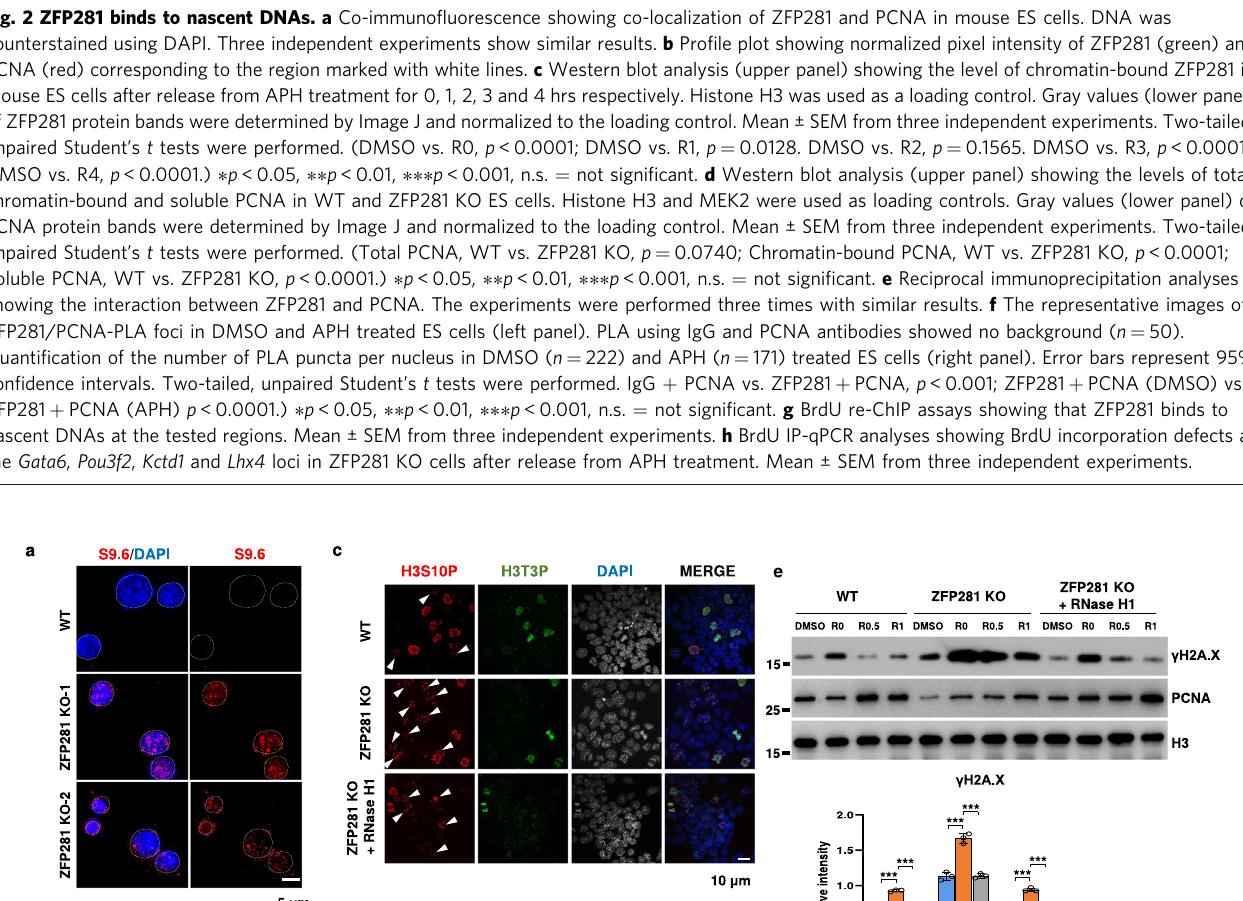
Fig. 2 ZFP281 binds to nascent DNAs. a Co-immuno fl uorescence showing co-localization of ZFP281 and PCNA in mouse ES cells. DNA was counterstained using DAPI. Three independent experiments show similar results. b Pro fi le plot showing normalized pixel intensity of ZFP281 (green) and PCNA (red) corresponding to the region marked with white lines. c Western blot analysis (upper panel) showing the level of chromatin-bound ZFP281 in mouse ES cells after release from APH treatment for 0, 1, 2, 3 and 4 hrs respectively. Histone H3 was used as a loading control. Gray values (lower panel) of ZFP281 protein bands were determined by Image J and normalized to the loading control. Mean ± SEM from three independent experiments. Two-tailed, unpaired Student ’ s t tests were performed. (DMSO vs. R0, p < 0.0001; DMSO vs. R1, p = 0.0128. DMSO vs. R2, p = 0.1565. DMSO vs. R3, p < 0.0001. DMSO vs. R4, p < 0.0001.) ∗ p < 0.05, ∗∗ p < 0.01, ∗∗∗ p < 0.001, n.s. = not signi fi cant. d Western blot analysis (upper panel) showing the levels of total, chromatin-bound and soluble PCNA in WT and ZFP281 KO ES cells. Histone H3 and MEK2 were used as loading controls. Gray values (lower panel) of PCNA protein bands were determined by Image J and normalized to the loading control. Mean ± SEM from three independent experiments. Two-tailed, unpaired Student ’ s t tests were performed. (Total PCNA, WT vs. ZFP281 KO, p = 0.0740; Chromatin-bound PCNA, WT vs. ZFP281 KO, p < 0.0001; Soluble PCNA, WT vs. ZFP281 KO, p < 0.0001.) ∗ p < 0.05, ∗∗ p < 0.01, ∗∗∗ p < 0.001, n.s. = not signi fi cant. e Reciprocal immunoprecipitation analyses showing the interaction between ZFP281 and PCNA. The experiments were performed three times with similar results. f The representative images of ZFP281/PCNA-PLA foci in DMSO and APH treated ES cells (left panel). PLA using IgG and PCNA antibodies showed no background ( n = 50). Quanti fi cation of the number of PLA puncta per nucleus in DMSO ( n = 222) and APH ( n = 171) treated ES cells (right panel). Error bars represent 95% con fi dence intervals. Two-tailed, unpaired Student ’ s t tests were performed. IgG + PCNA vs. ZFP281 + PCNA, p < 0.001; ZFP281 + PCNA (DMSO) vs.